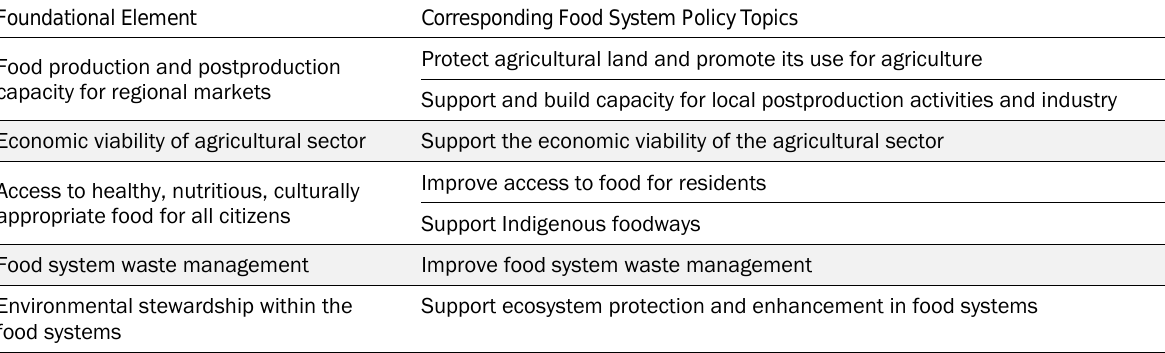
Table 2. The Five Foundational Elements of Regional Food Systems and Corresponding Food System Policy Topics